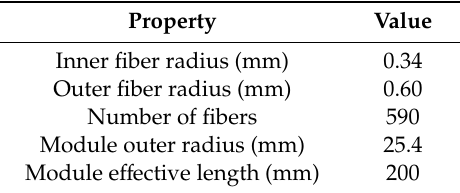
Table 1. Membrane module dimensions [23].